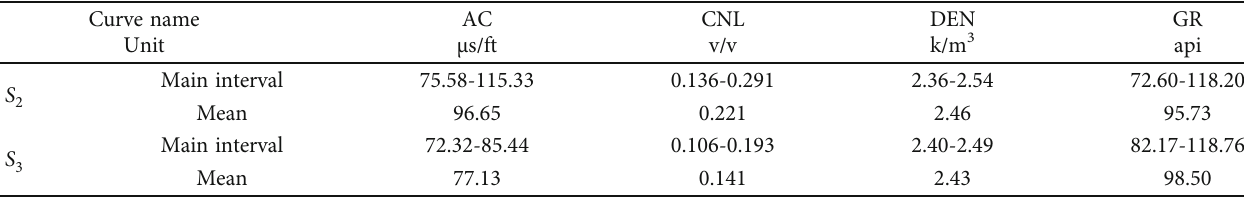
and S of well X1. 2 3 and S in well 2 3